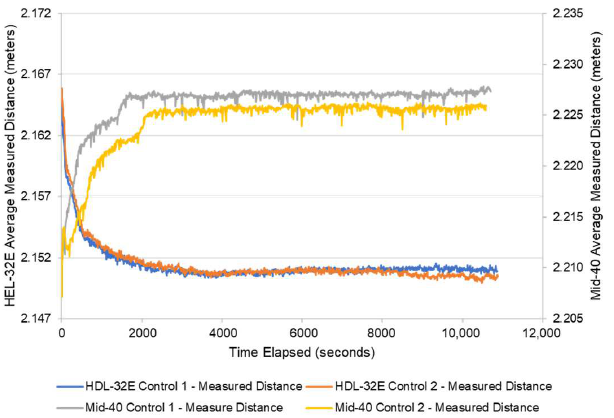
Figure 34. Temporal Stability of Velodyne ® HDL–32E and Livox ® Mid–40 during indoor experi- ments.